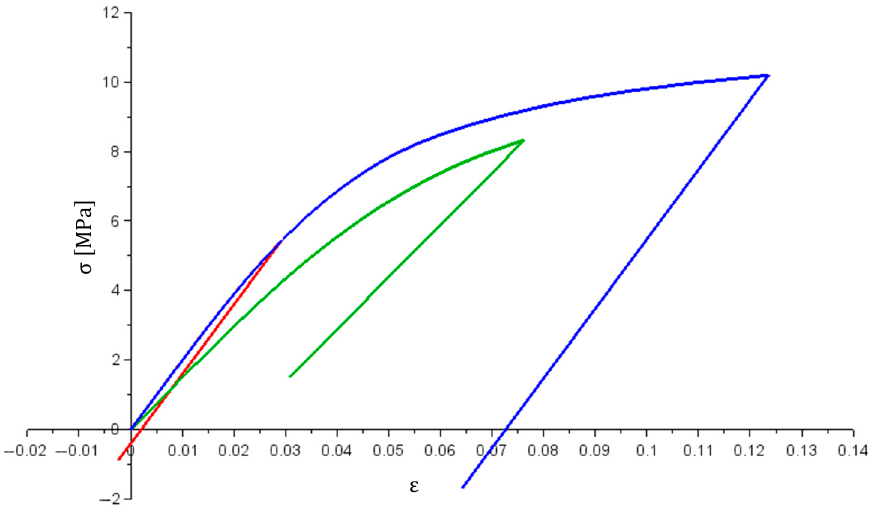
Figure 15. P i ( u i ) graph (i = 1—red; i = 2—green; i = 3—blue).